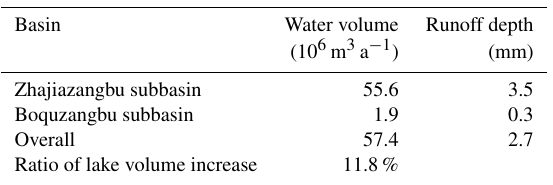
Table 5. Yearly volume of ground ice meltwater contribution in the Selin Co